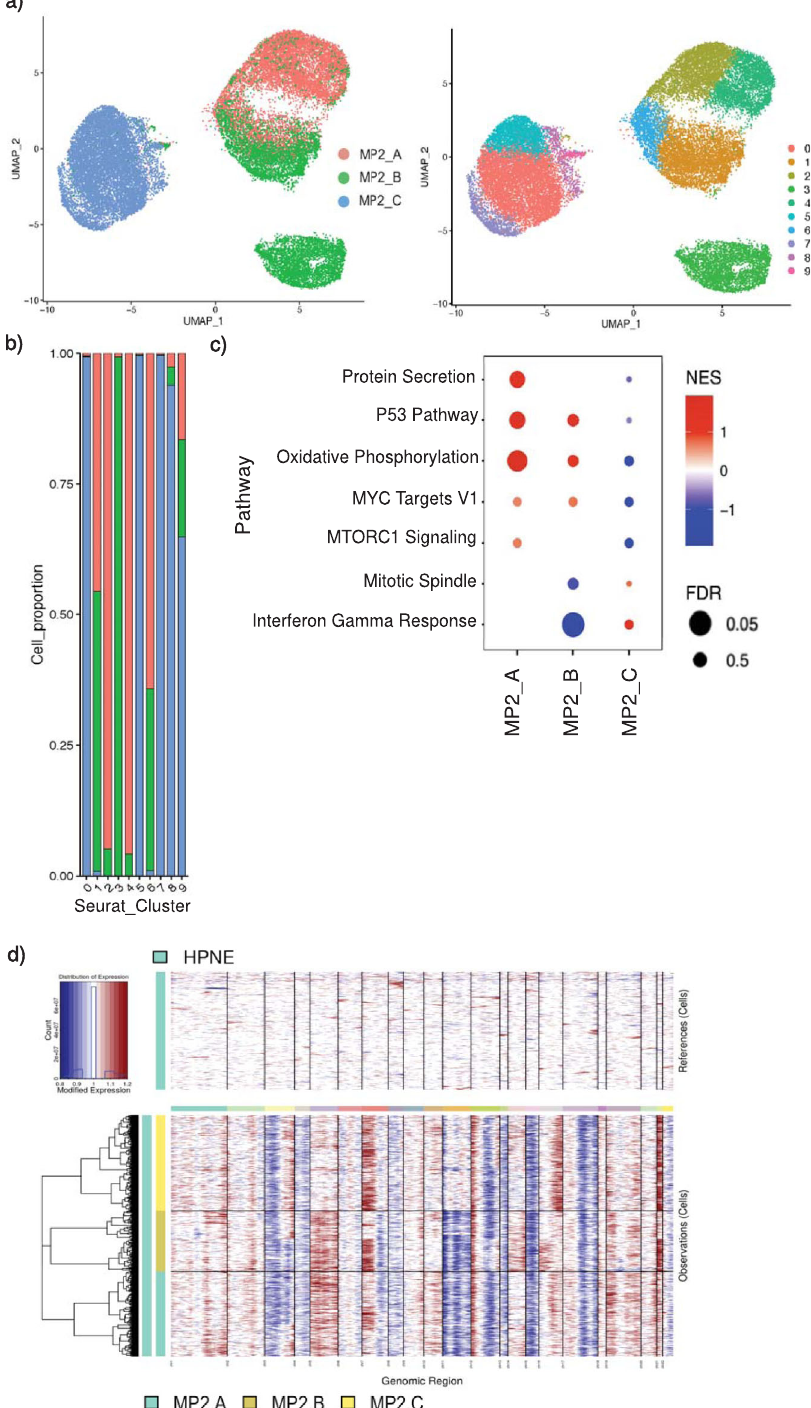
Fig. 3 Custodial variability of MiaPaca2 cell lines drives transcriptomic heterogeneity. a UMAP overlaying MP2 samples and their distinct clusters. b Bar graph displaying distribution of cells per MP2 culture across clusters; MP2-A in red, MP2-B in green and MP2-C in blue. c Bubble plot showing enrichment of pathways in MP2 cultures compared to each other with normalized enrichment score (NES) on the x-axis. Size of the bubble represents false discovery rate (FDR); red indicates upregulation, blue indicates downregulation of the pathway. d inferCNV heatmaps derived from scRNAseq data of all three MP2 samples, using HPNE as an analytical